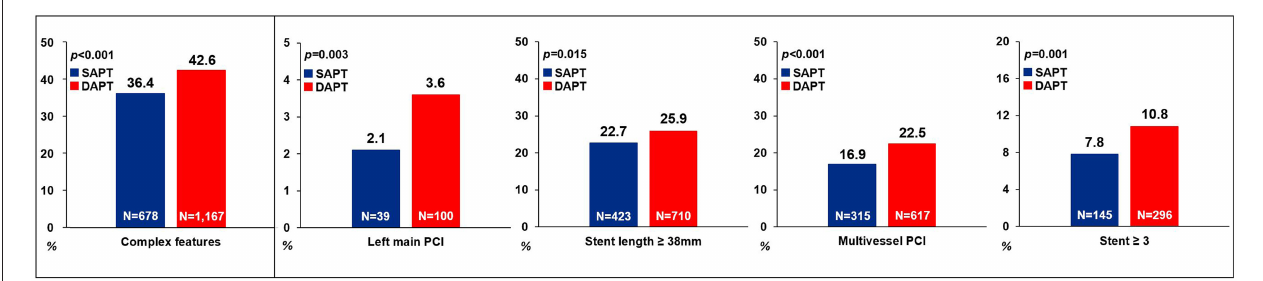
FIGURE 4 | Comparison of complex features between the SAPT and DAPT groups. SAPT, single antiplatelet therapy; DAPT, dual antiplatelet therapy; PCI, percutaneous coronary intervention.